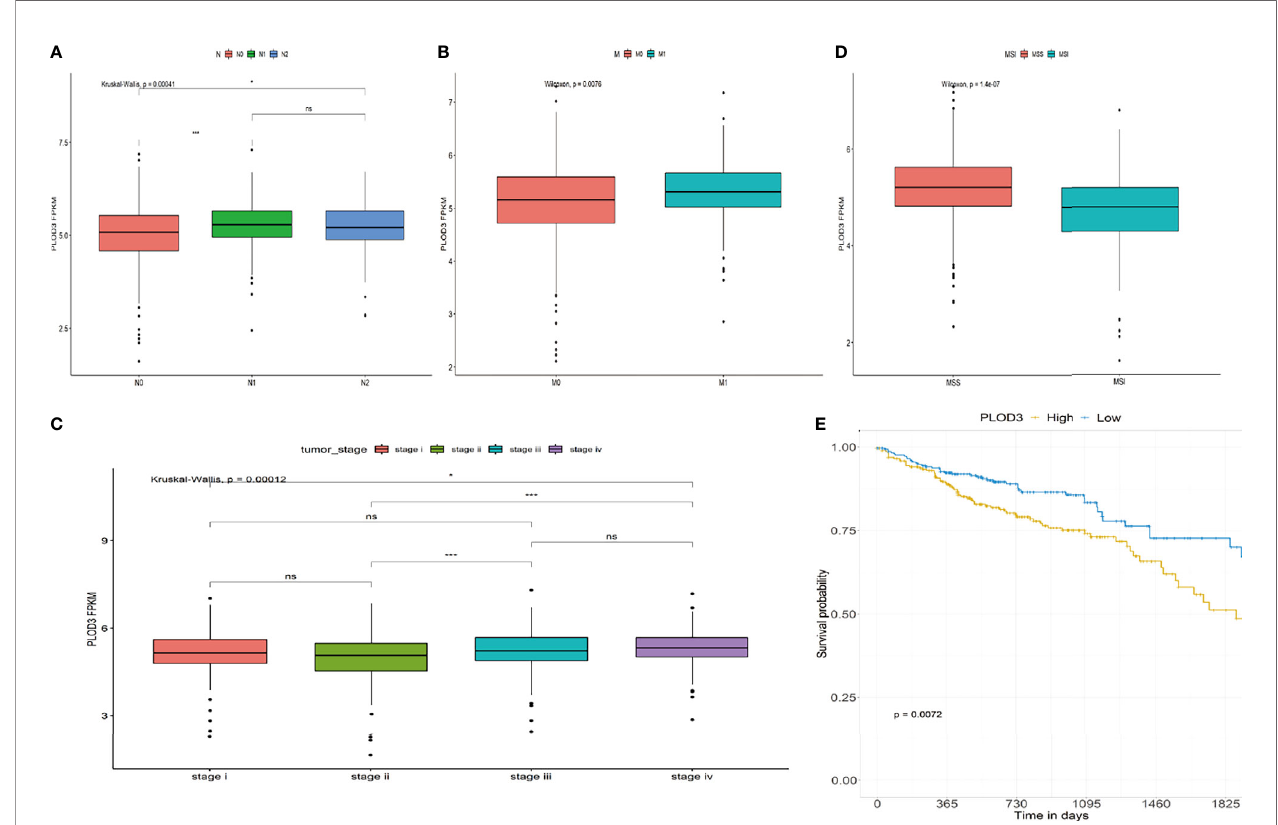
FIGURE 2 | Association of PLOD3 expression with clinicopathological characteristics, including (A) CRC N stage, (B) CRC M stage, (C) CRC pathologic stage, (D) MSI and MSS, and (E) overall survival (OS). * p < 0.05, *** p < 0.001, ns, No Signi fi